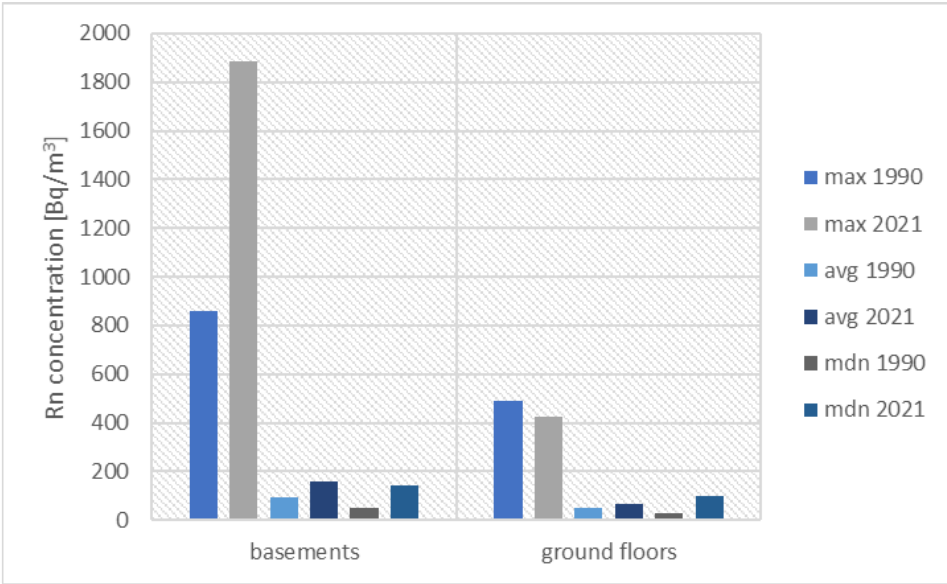
Figure 5. Comparison of radon concentrations in buildings in Piekary Śląskie measured in the 1990s and nowadays.